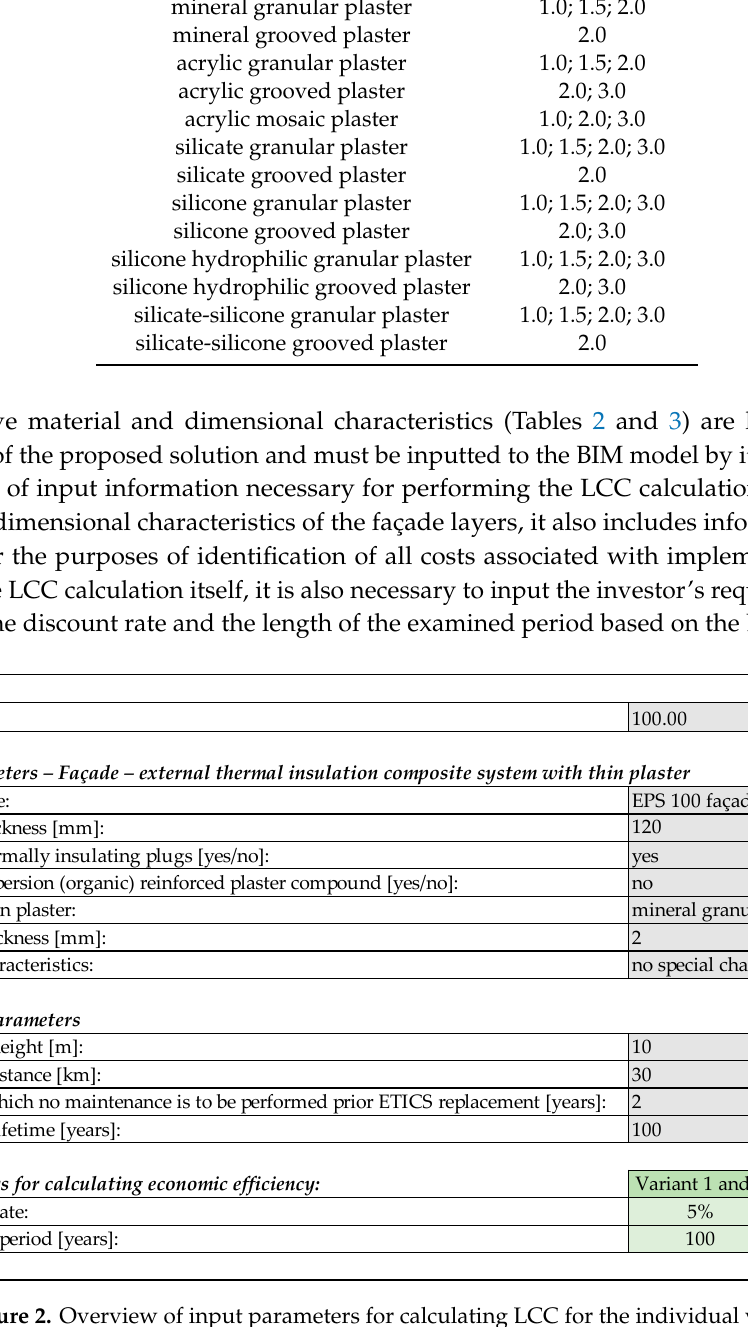
Figure 2. Overview of input parameters for calculating LCC for the individual variants.